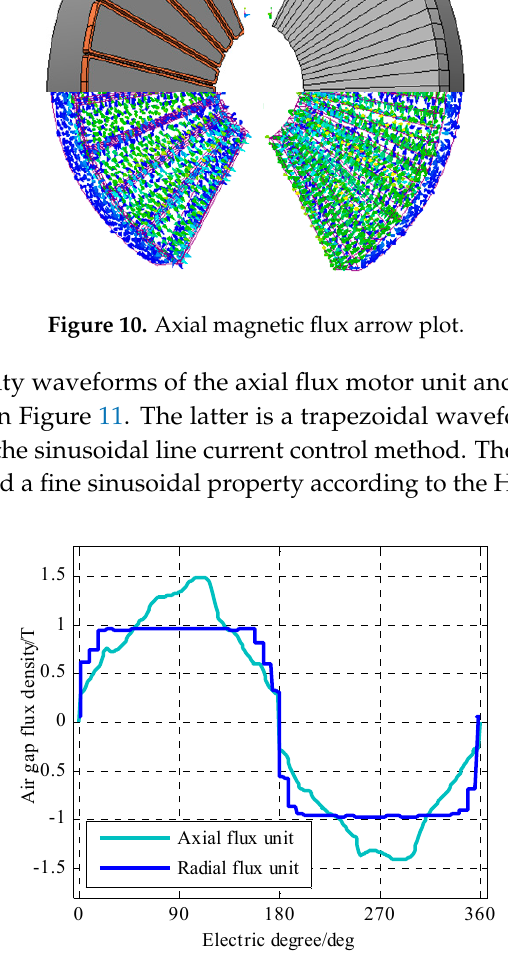
Figure 11. Flux density distribution.